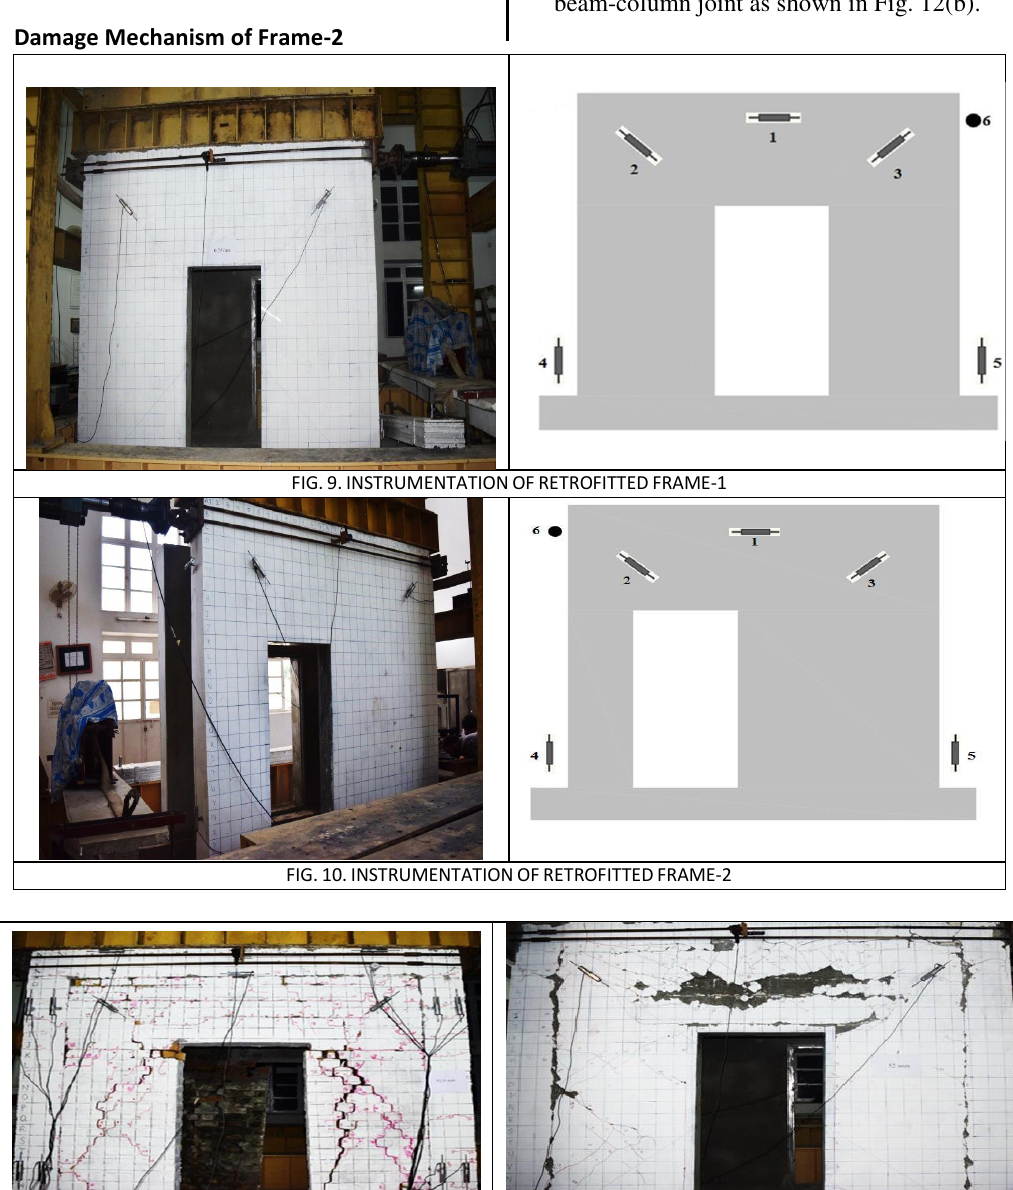
FIG.11. DAMAGE PATTERN OF FRAME-1 (A) BEFORE RETROFITTING (B) AFTER